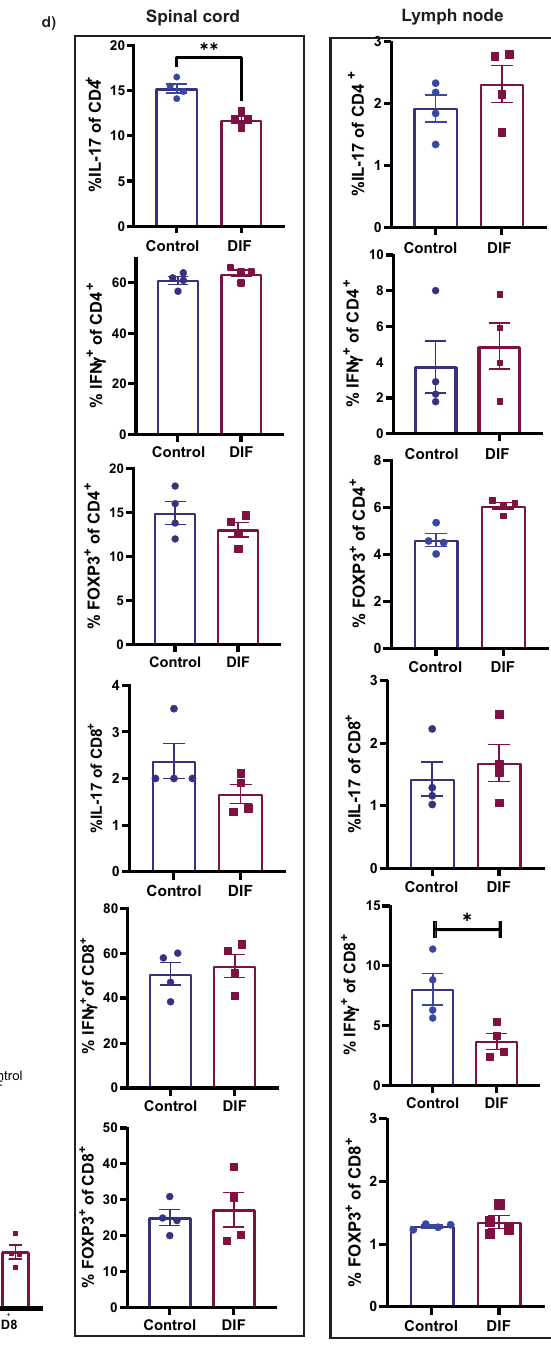
Fig. 5 Di fl uorosamine reduces Th17 population in the CNS during EAE. a A CSPG-lowering drug, di fl uorosamine (DIF), was administered at 25 mg/kg to mice daily starting three days post onset of EAE for 5 days. Data are presented as mean ± SEM of n = 10 mice per group pooled from 2 independent experiments. Results were analyzed using two-way repeated-measures ANOVA with Sidak ’ s post-hoc test; * p = 0.02. Average EAE clinical score of mice is shown with treatment period indicated by green box. b The frequency of different T cell subsets was determined using fl ow cytometry. c Bar graphs showing the frequency of CD3 + , CD4 + and CD8 + cells; and d IFN- γ + , IL-17 + or FOXP3 + T cells within the CD4 + or CD8 + populations in the spinal cord and lymph nodes of DIF or vehicle treated mice. Data are presented as mean ± SEM. n = 4 mice per group for c , d , and results were reproduced in a second experiment (source data fi le). Two-tailed unpaired Student ’ s t test; ** p = 0.003 for c , and * p = 0.025 or **0.0017 for d . Source data are provided in the source data fi le. The association between T cell subsets and levels of versican- immune responses and how they impact remyelination have yet V1 within lesions may be studied further using RNAscope that to be explored thoroughly in the context of versican biology. Our provides better sensitivity and speci fi city (relative to spatial RNA future studies using versican conditional knock out mice would sequencing) to measure low-abundance RNA biomarkers such as help to clarify the speci fi c effect of versican rather than total IL-17 and ROR γ T. In addition to T cells, the changes in innate CSPGs on immune cells during remyelination. NATURE COMMUNICATIONS| (2022) 13:2445